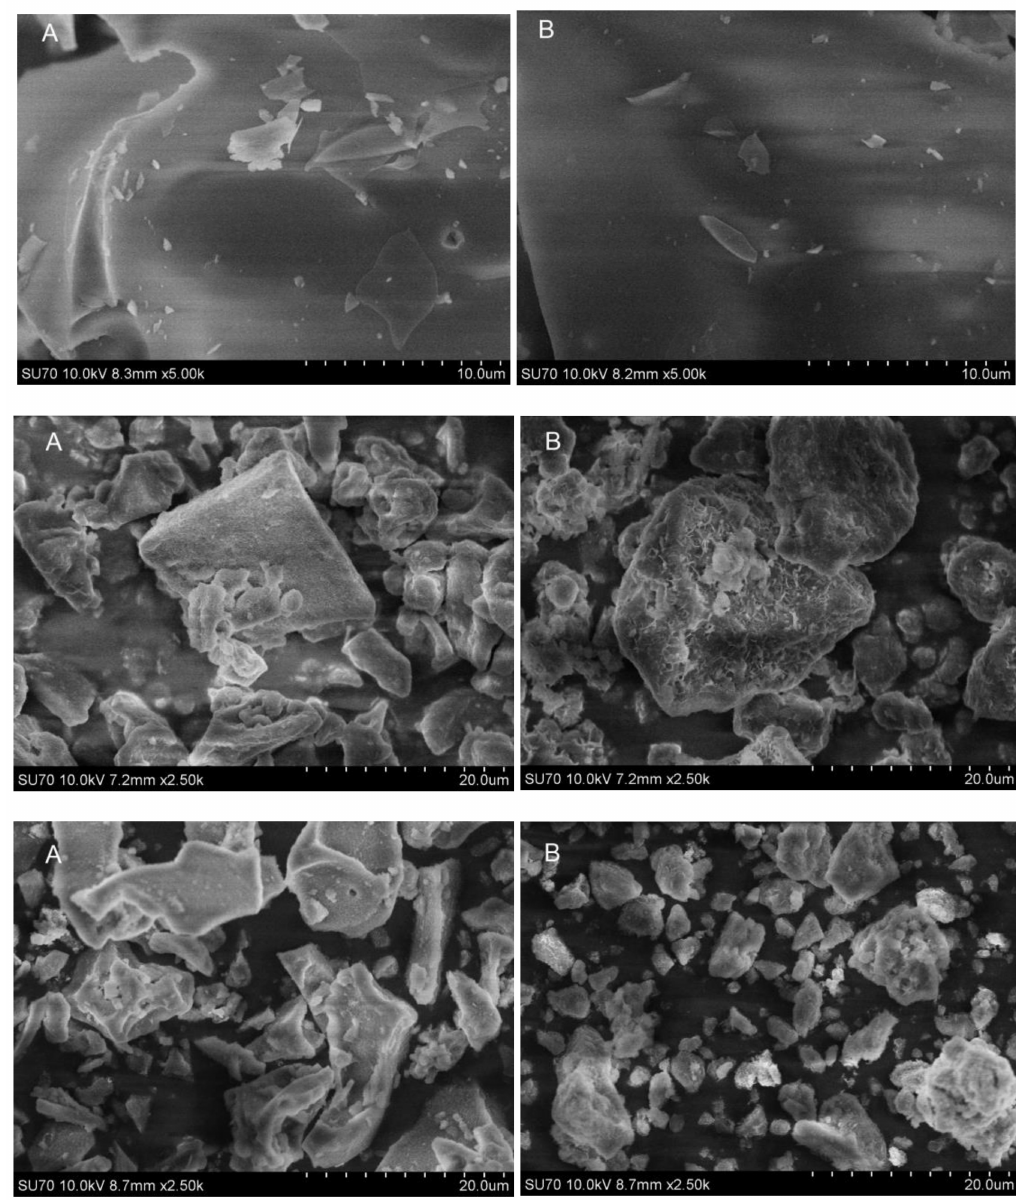
Figure 11. SEM micrographs of MMO obtained by heating the Mg 1.95 Ba 0.05 / Al 1 precursor gels ( top ), sol–gel derived Mg 1.95 Ba 0.05 / Al 1 LDHs ( middle ) and MMO obtained by heating the Mg 1.95 Ba 0.05 / Al 1 LDHs ( bottom ). Annealing temperatures: 800 ◦ C ( A ) and 950 ◦ C ( B ). Thus, the isotherms and hystereses are dependent on both synthesis pathway and annealing temperature. The nitrogen adsorption–desorption results obtained for the mixed metal oxides containing Ca, Sr, and Ba (Figure 13) demonstrated that the N 2 adsorption–desorption isotherms show very similar